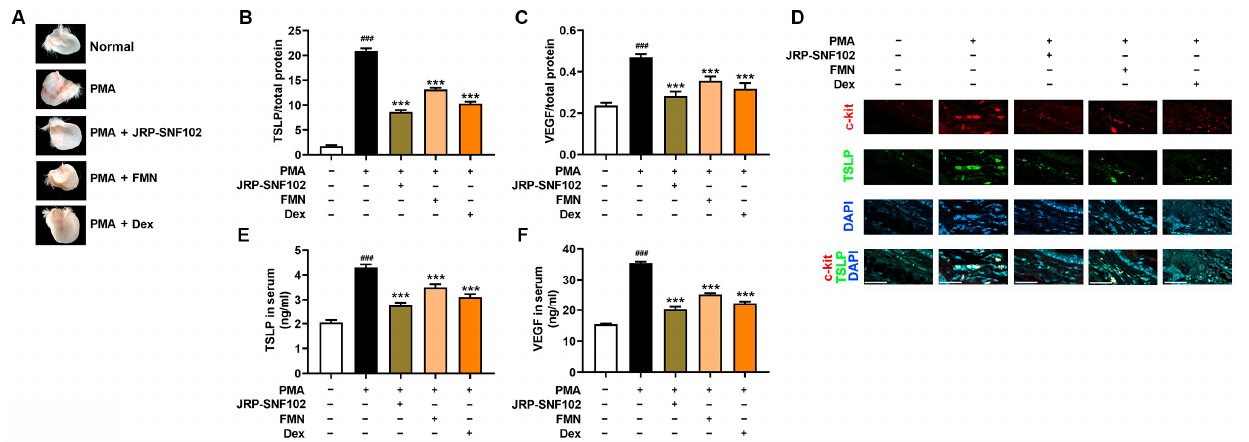
Figure 5. A suppressive effect of JRP-SNF102 or FMN on TSLP levels in PMA-induced ear edema. ( A ) The photographs of ear biopsies were obtained after ear thickness analysis. The ear biopsies were prepared for determining ( B ) TSLP and ( C ) VEGF levels by ELISA. ( D ) In the ear biopsies, c-kit (+) and TSLP (+) cells were observed with a confocal microscope, scale bar = 50 µm. ( E ) TSLP and ( F ) VEGF levels in serum samples were quantified by ELISA. ### p < 0.001 versus normal group; *** p < 0.001 versus PMA-challenged groups. n = 6. -, non-treatment; +, treatment.